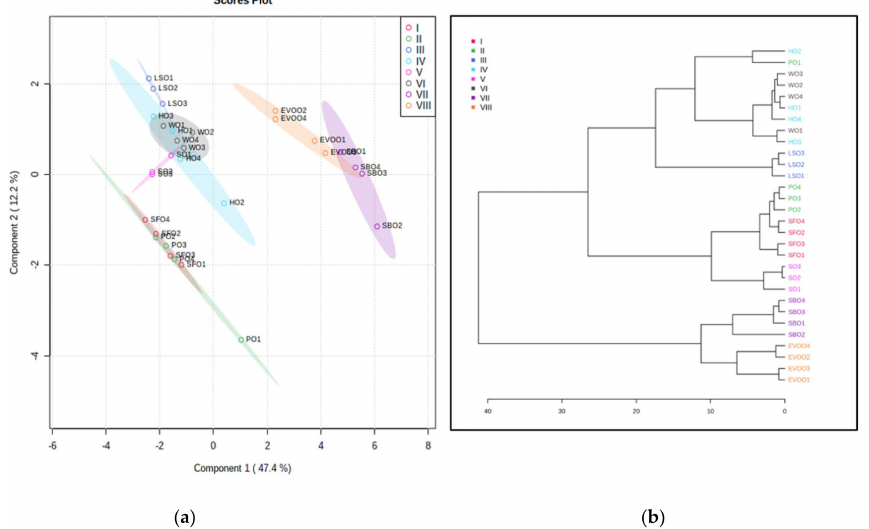
Figure 6. Partial least squares with discriminant analysis (PLSDA) score plot and dendrogram cluster analysis for the 8 groups of oils (I to VIII). For the group individual affiliation and abbreviations see Table 1. ( a ) Partial least squares with discriminant analysis (PLSDA) score plot ( b ) and dendrogram cluster analysis for the 8 groups of oils (I to